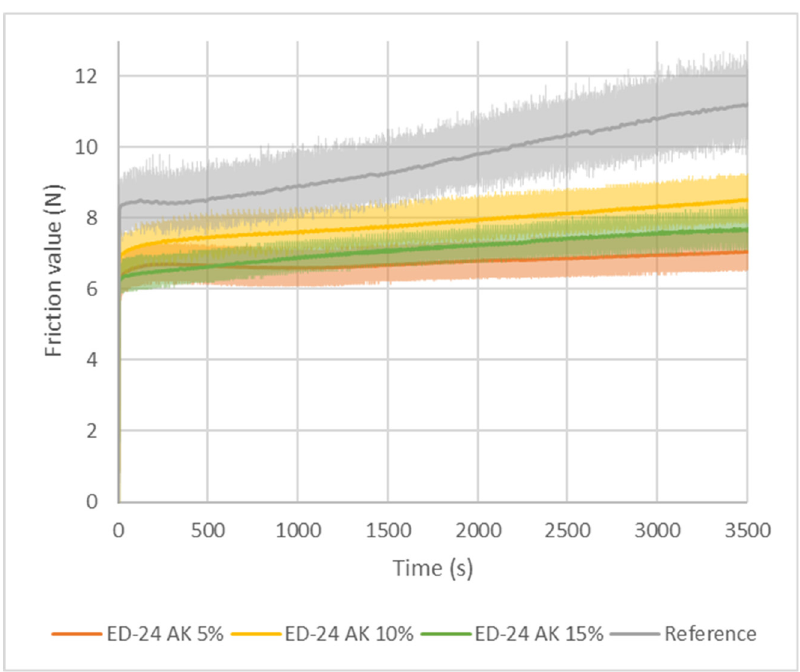
Figure 13. Friction characteristics of NBR modified with the addition of ED-20.